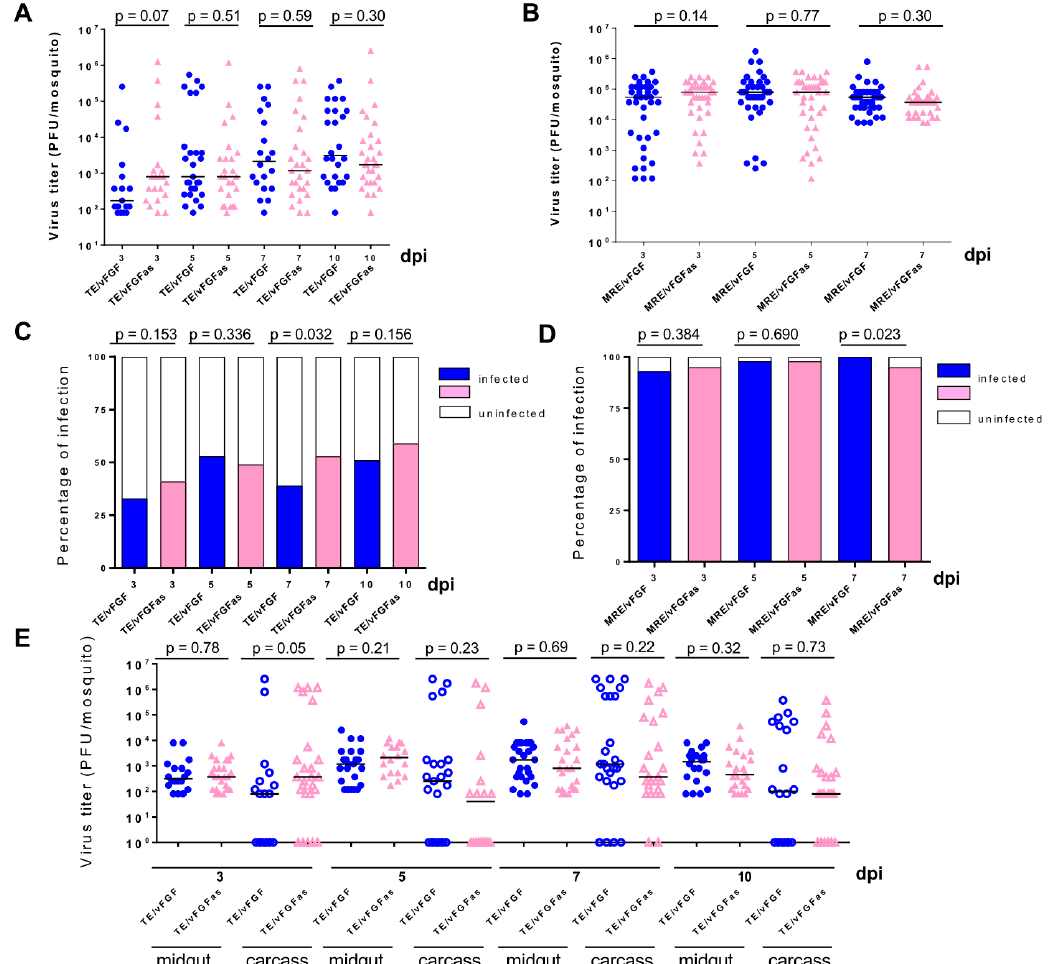
Figure 7. Expression of vFGF does not increase SINV replication and dissemination in mosquitoes. TE/vFGF or TE/vFGFas ( A ) and MRE/vFGF or MRE/vFGFas ( B ) replication in individual mosquitoes was measured by TCID 50 assays. Only infected mosquitoes were included in the analyses and Mann- Whitney U tests were used to determine p values. The prevalence of virus infection of TE/vFGF or TE/vFGFas ( C ) and MRE/vFGF or MRE/vFGFas ( D ) in mosquitoes based on titered samples was obtained. Significance was determined by Fisher’s Exact test. ( E ) Individual midguts were titered separately from the carcass of the mosquitoes. Only carcasses with a corresponding infected midgut were included in the analysis. Mann-Whitney U tests were used to determined p